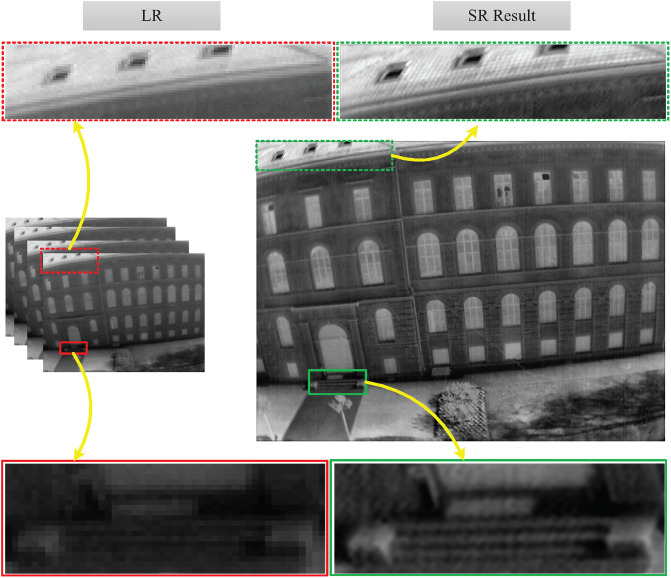
Experimental result of Target 1.